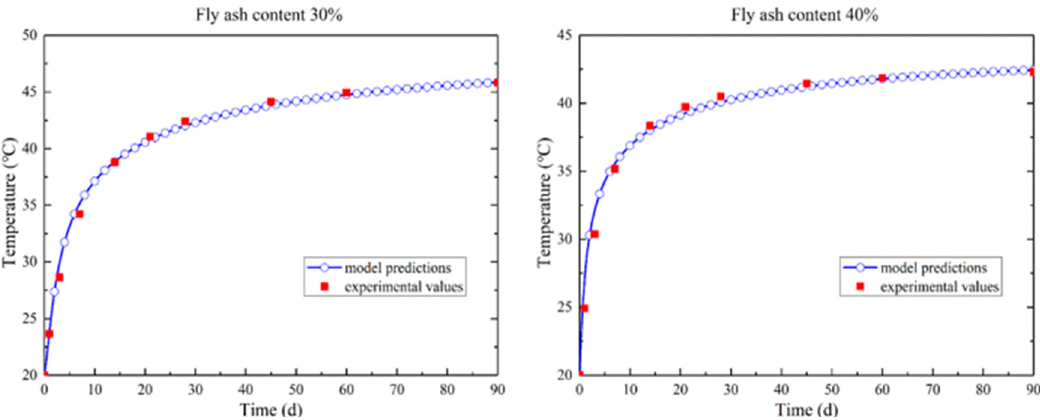
Figure 1. Temperature evolution of magnesium oxide concrete (fly ash content 30% and 40%) under adiabatic conditions.